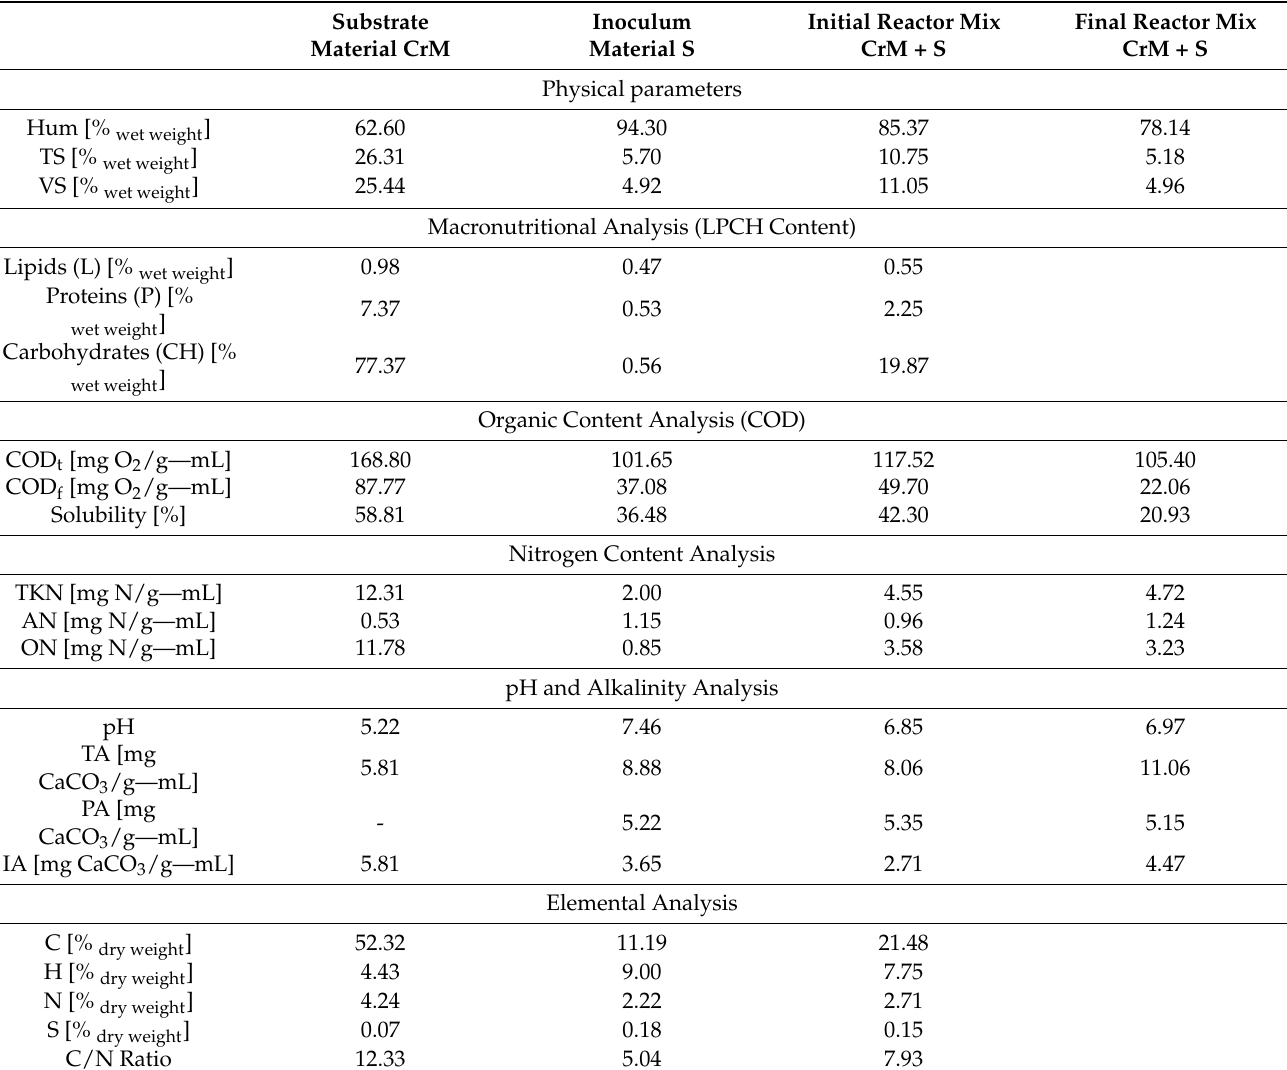
Table 2. Characterization results for BMP tests of residue CrM, at the start and after completion of the test.